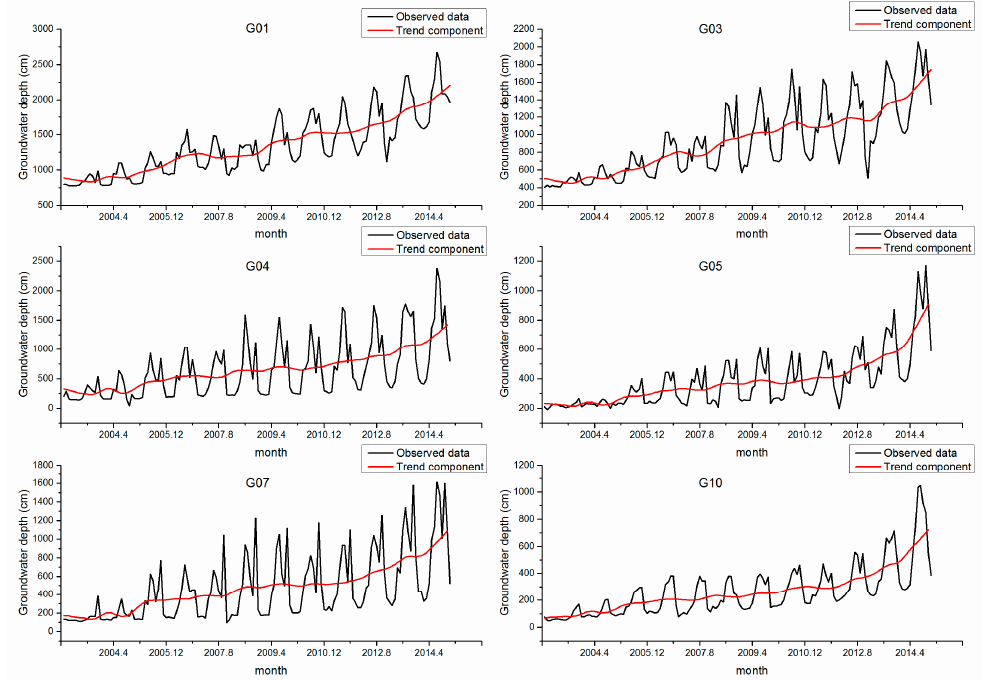
Figure 4. Groundwater monthly fluctuations of observed wells (black line), 2002–2014, and trend component (red line) from the Seasonal-trend decomposition based on the LOESS (STL) decomposition.